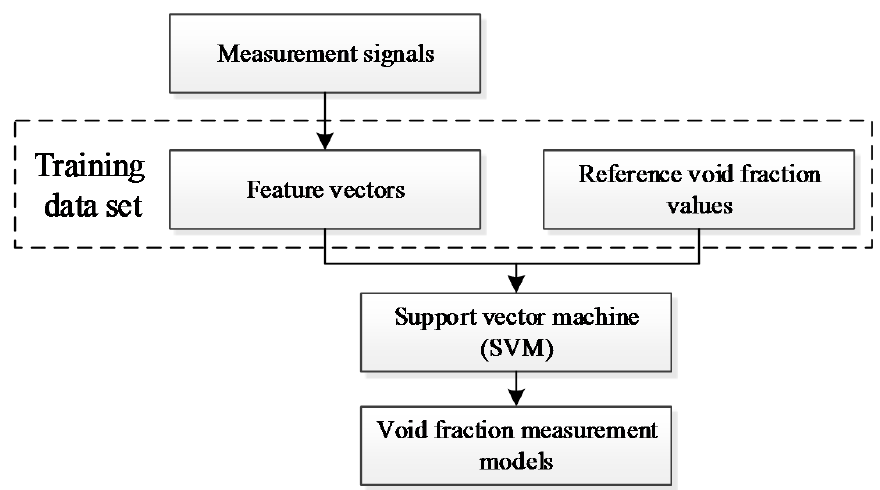
Figure 5. The flowchart of the void fraction measurement model development.